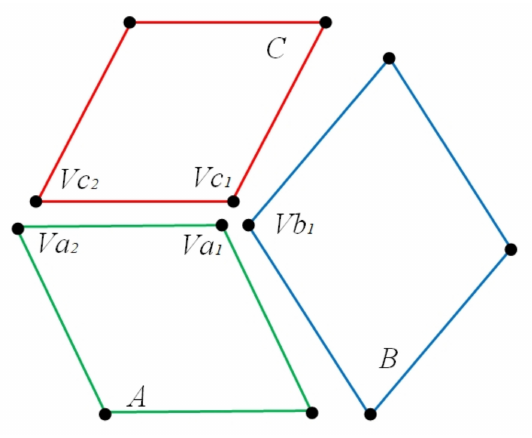
Figure 2. Graphic illustration of the two types of topological relations. In polygons A , B , and C , if edge ( Va 1 , Va 2 ) matches edge ( Vc 1 , Vc 2 ), then the polygon pair ( A , C ) is considered to be pairwise adjacent. If vertices Va 1 , Vb 1 , and Vc 1 are matched with each other, then polygon triplet ( A , B , C ) is considered to intersect at the common point of the three supporting